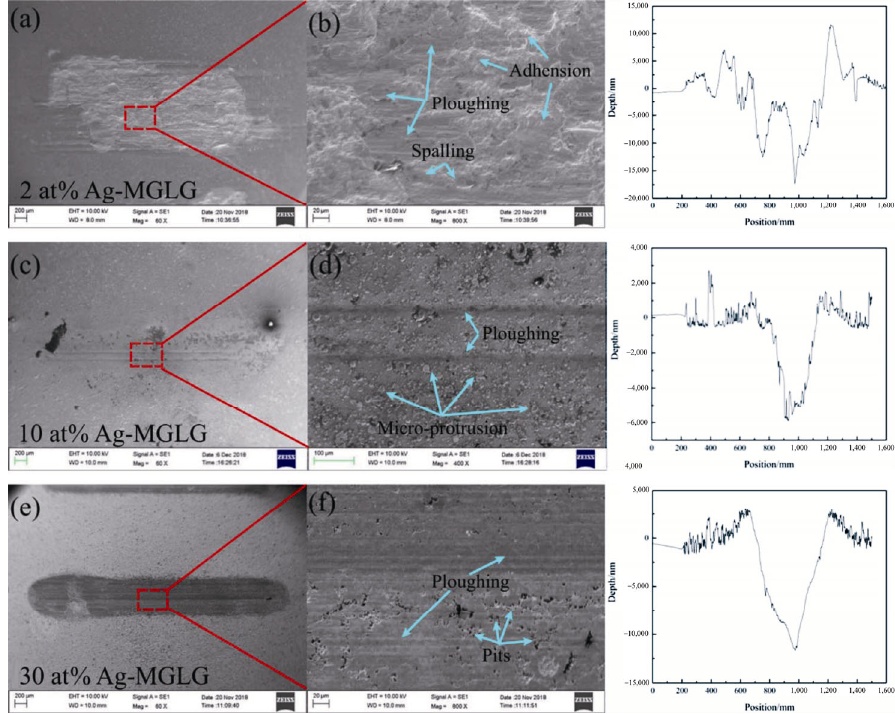
Fig. 8 SEM morphologies of (a) worn surfaces and (b) TiN–Ag coatings with 2 at% Ag content; (c, d) TiN–Ag coatings with 10 at% Ag content; (e, f) TiN–Ag coatings with 30 at% Ag content under MGLG (voltage:1.5 V; load:15 N; frequency: 2 Hz; stroke: 4